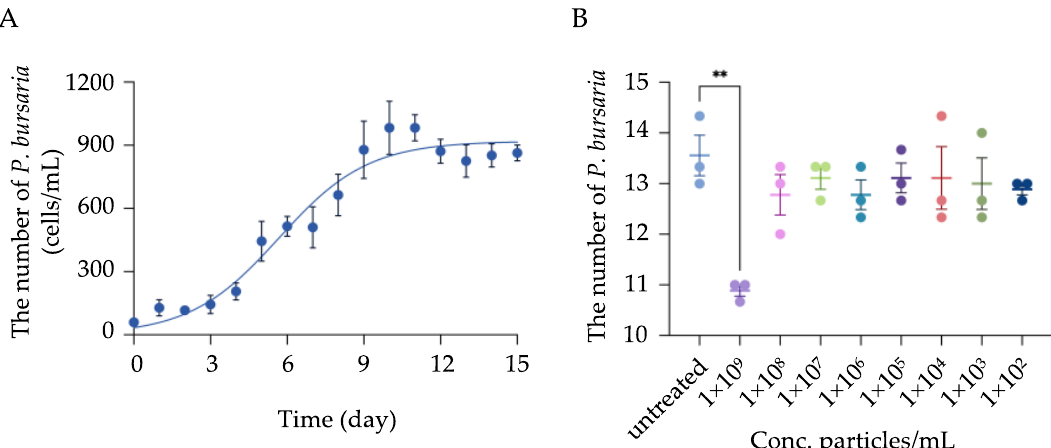
Figure 1. Determination of toxic concentration of MPs on P. bursaria proliferation. ( A ) To determine the growth kinetics of P. bursaria , cells were initially seeded at the density of 60 cells/mL (Day 0) in E3 medium supplemented with TG1 as a food source and cultured under a 12:12 light–dark period. Cells were manually counted every 24 h for 15 days, after which the growth curve was plotted and fitted using nonlinear regression analysis. Each dot represents the mean ± SD of three independent experiments. ( B ) Evaluation of toxic effects on P. bursaria proliferation following MPs exposure. P. bursaria (10 cells/group) at the logarithmic growth phase were collected and subjected to various concentrations of MPs ranging from 1 × 10 2 to 1 × 10 9 particles/mL. After 24 h exposure, viable P. bursaria were manually counted and compared to the control group (i.e., untreated group). The data are represented as the mean ± SD of three independent experiments, and asterisks above the line denote a significant difference (** p < 0.01) between means identified by the line.